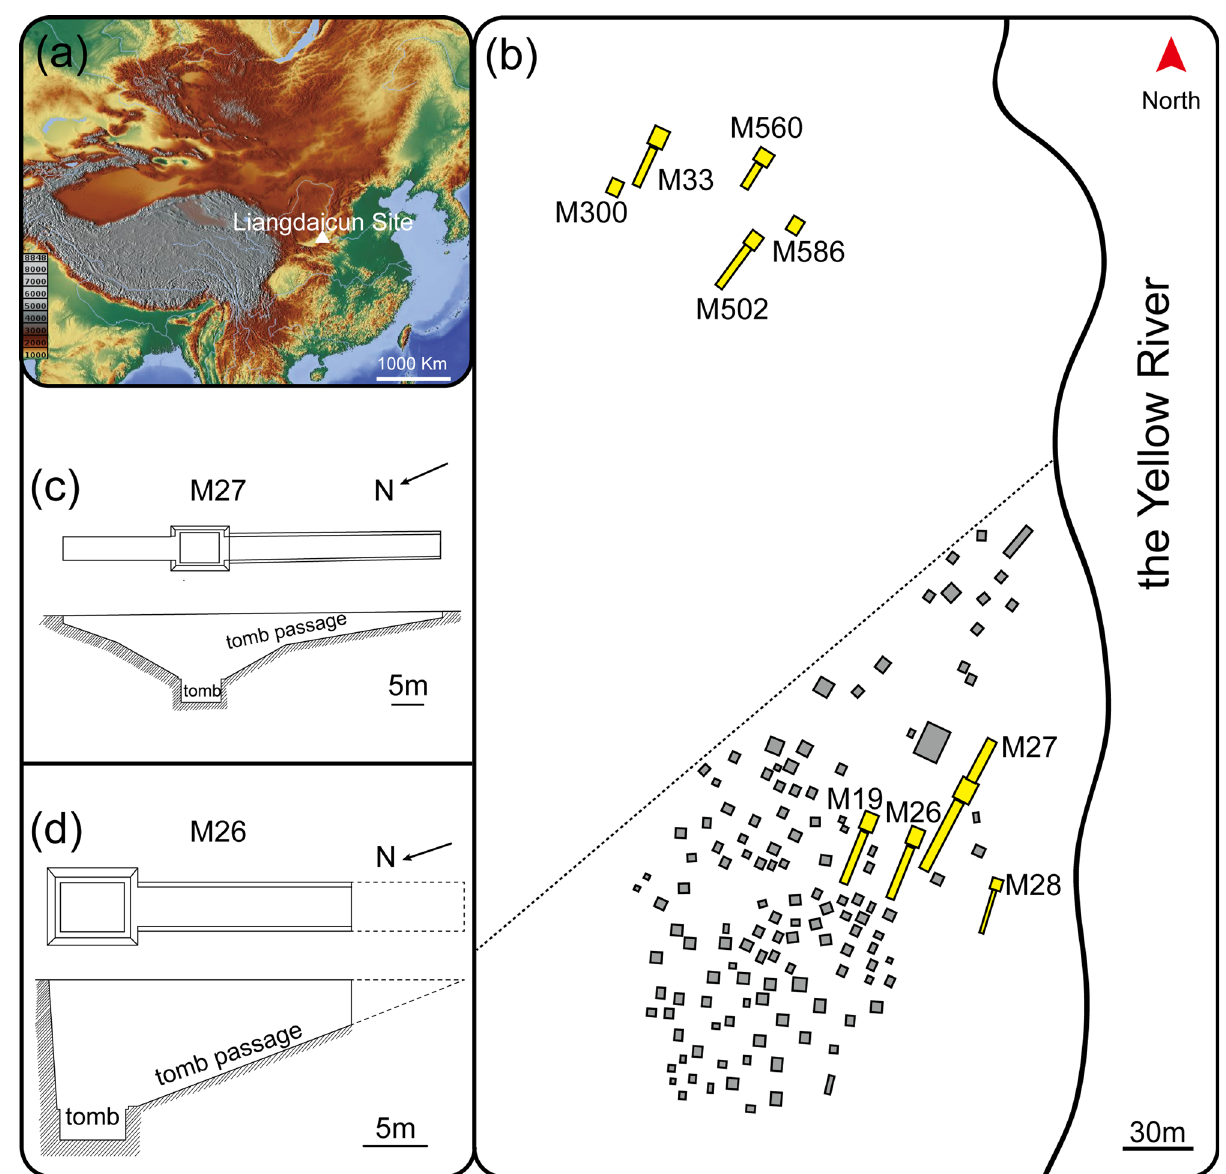
Fig. 2 The location and layout of the Liangdaicun site. a The location of the Liangdaicun site in northern China and b the location of tombs M26, M27 and M300 within the Liangdaicun site. In b , the yellow symbols (mostly with tomb passage) represent tombs of the aristocratic class, and the gray symbols represent tombs of civilians. Most of the tombs above the dashed line are not shown in the map except M300, M33, M502, M560 and M586. c is the plane graph of tomb M27 (occupier Ruigong , a king of Rui state) and d is the plane graph of tomb M26 (occupier Zhongjiang , a queen of Rui state). The graphs are in reference to the archeological report of the Liangdaicun site. M26 is a “ 甲 ” -shaped tomb with one tomb passage, while M27 is a “ 中 ” -shaped tomb with two tomb passages ( “ 甲 ” and “ 中 ” are typical tomb shapes for nobilities and elite burials during that